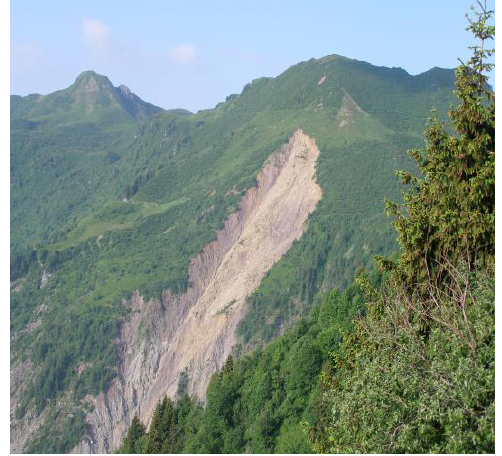
Figure 1. The body of the